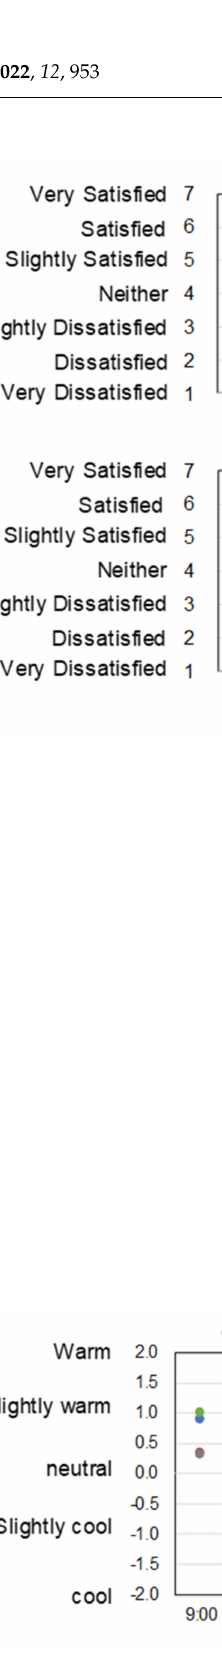
Figure 10. Prediction of PMV in summer and